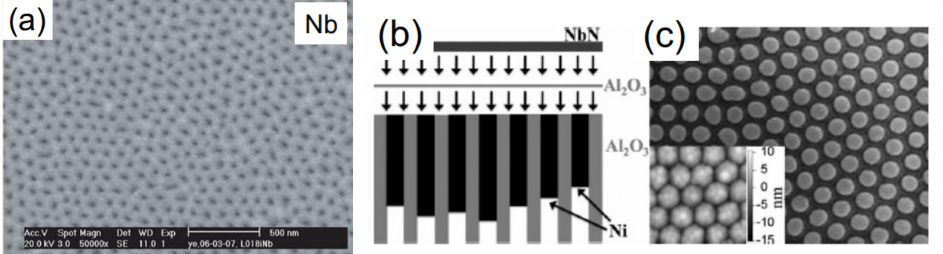
Figure 10. ( a ) Image of a 50-nm thick Nb film evaporated on top of an AAO template. The porous structure is inherited from the AAO template beneath, Reprinted with permission Ref. [46].